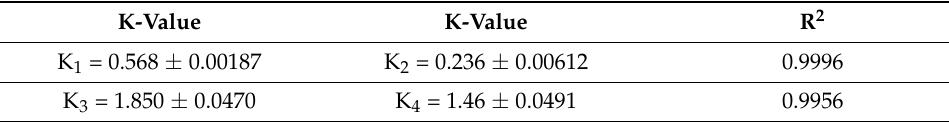
Figure A6. Plot of σ (cid:2913) /C b against tanθ fitted with Equation (A2).